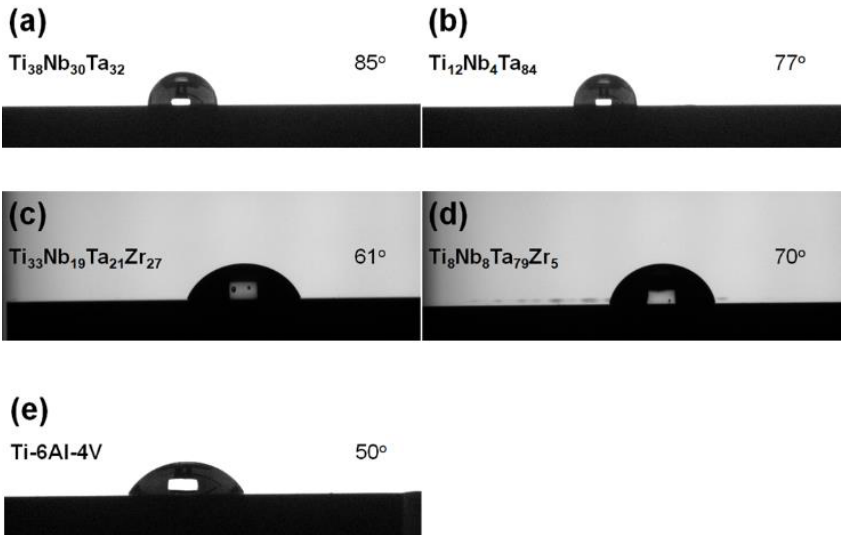
Figure 5. Water contact angles on ( a ) Ti 38 Nb 30 Ta 32 , ( b ) Ti 12 Nb 4 Ta 84 , ( c ) Ti 33 Nb 19 Ta 21 Zr 27 , and ( d ) Ti 8 Nb 8 Ta 79 Zr 5 films and ( e ) bare Ti – 6Al – 4V substrate. Figure 6a depicts the XTEM image of the Ti 33 Nb 19 Ta 21 Zr 27 film after immersion in Ringer’s solution for eight weeks. The Ti 33 Nb 19 Ta 21 Zr 27 film exhibited a typical columnar